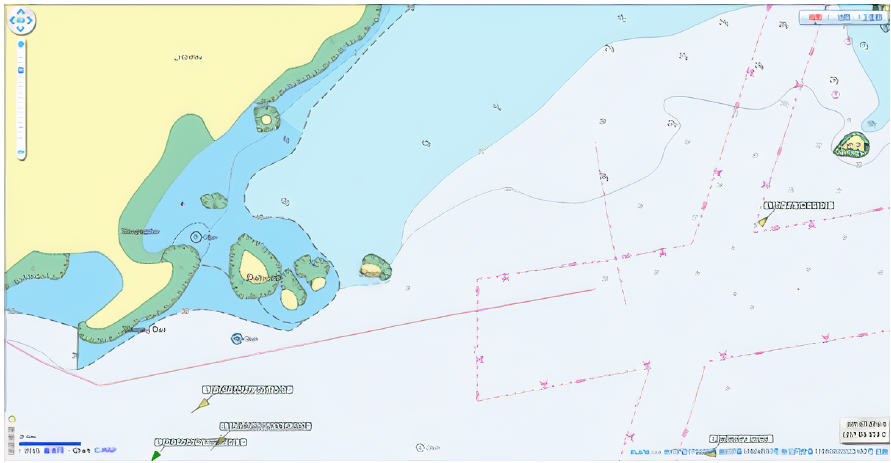
Figure 9. Chart scene. Table 3. Data for multiple dynamic obstacle